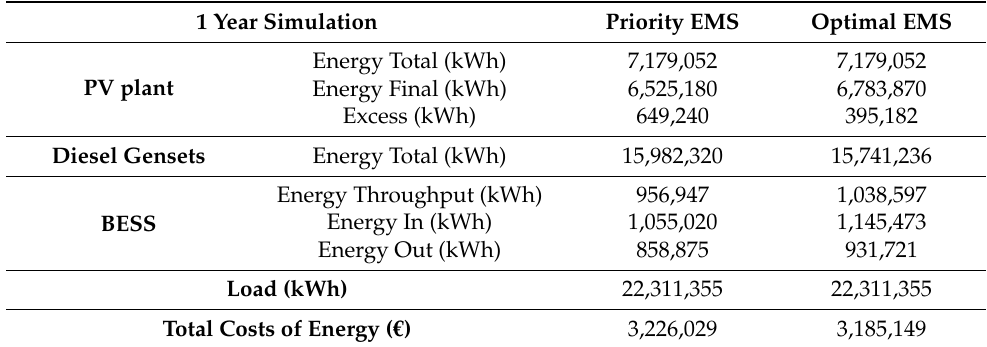
Table 3. Results with accumulated